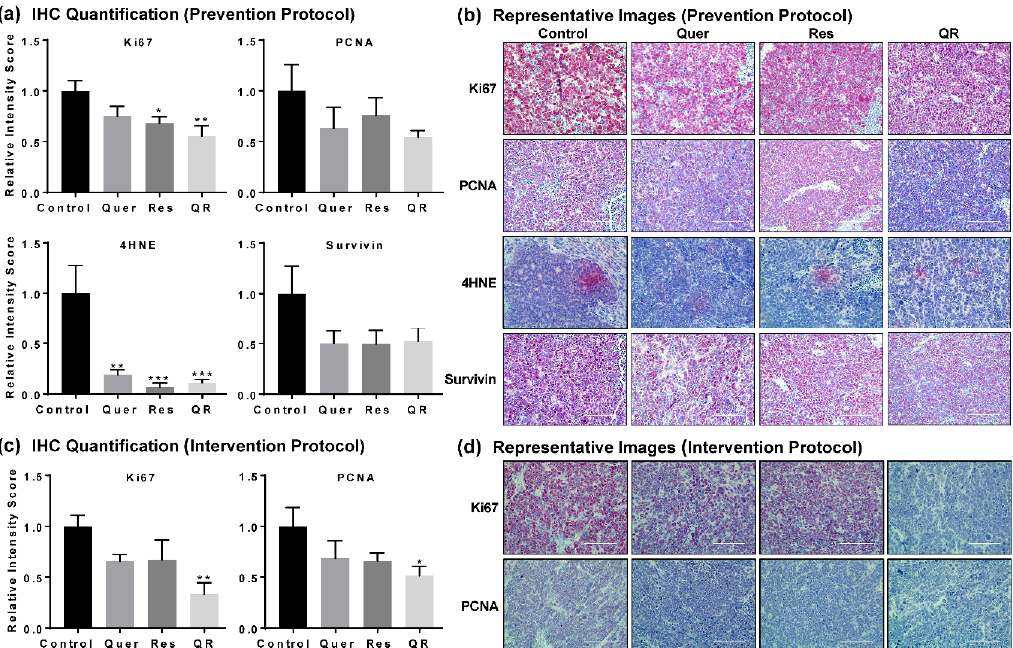
Figure 2. Quercetin–resveratrol supplementation inhibits markers of cell proliferation, oxidative stress, and tumor survival in prostate cancer. ( a ) Semi-quantitative immunohistochemical (IHC) analysis and ( b ) representative images of proliferative markers Ki67 and PCNA, oxidative stress biomarker 4HNE, and tumor survival marker Survivin with tumor tissues from the prevention setting. ( c ) Semi-quantitative and ( d ) representative images of IHC analysis of Ki67 and PCNA in the intervention setting. Images were obtained at 10, 20 and 40× magnification for the overall analysis of the tissue samples, however, only representative images at 40× magnification are presented here. Semi-quantitation was performed using ImageJ Fiji (version 1.2) and statistical significance was determined using GraphPad Prism 5 software using one-way ANOVA followed by uncorrected Fisher’s LSD test (* p <0.05, ** p <0.01, *** p <0.001). The data presented are mean ± SEM of six animals per group.